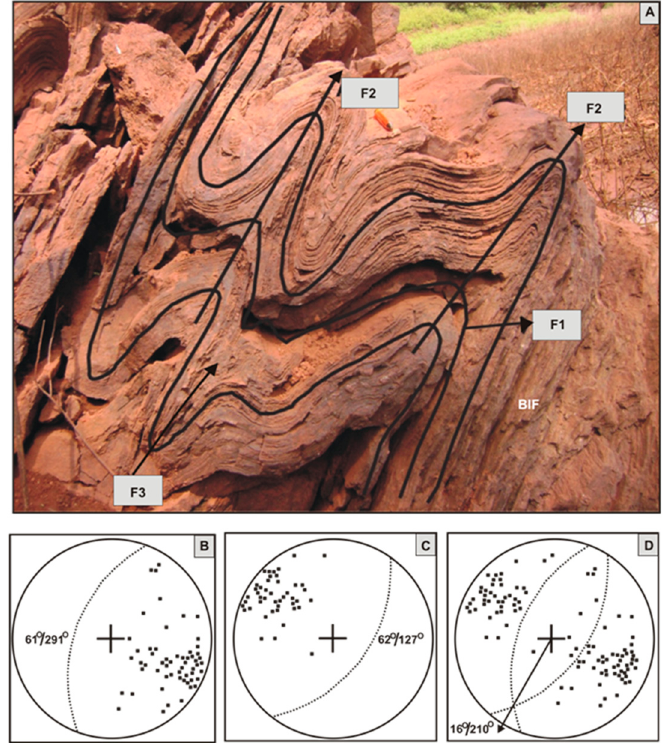
Figure 8. ( A ) Superposed pattern of folds (F 1 , F 2 and F 3 ) developed in BHJ; ( B ) equal angle projection of the poles of the bedding data which are dipping towards west; ( C ) poles of bedding data dipping towards east; and ( D ) equal-angle projection of the poles of the bedding. The arrow mark shows the overall plunge (towards south) of the iron formation. The maximum cluster of data points of bedding are towards the eastern and western side, which indicates that the overall structural geometry of KMIOD is antiformal in nature because the dip of the beds is away from each other.